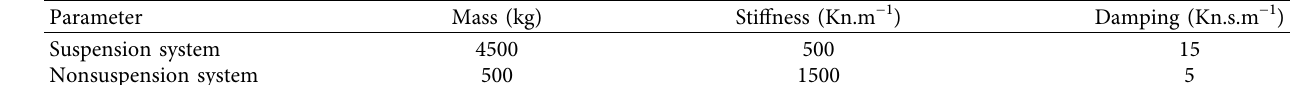
Figure 13: Vehicle-road coupling vibration simulation model based on the random excitation of road surface roughness. Table 4: Medium-sized vehicle parameters.